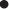
Ser degradation activity of Wild-type (WT) and dsd-null strain. (A)
D-Ser degradation activity in the cell-free extract of WT () and dsd-null cells (). Data are represented as the mean ± SD (n = 3). (B) Identification of the keto acid product formed from D-Ser by the cell-free extract of WT (3) and dsd-null cells (4). Elution profiles of the MBTH-derivatized pyruvate (1) and hydroxypyruvate (2) are also shown as controls. α-Ketoglutarate was used as an internal standard for the derivatization of keto acids as described previously (Ito et al., 2008). Samples after 7.5 h incubation were used for this analysis.